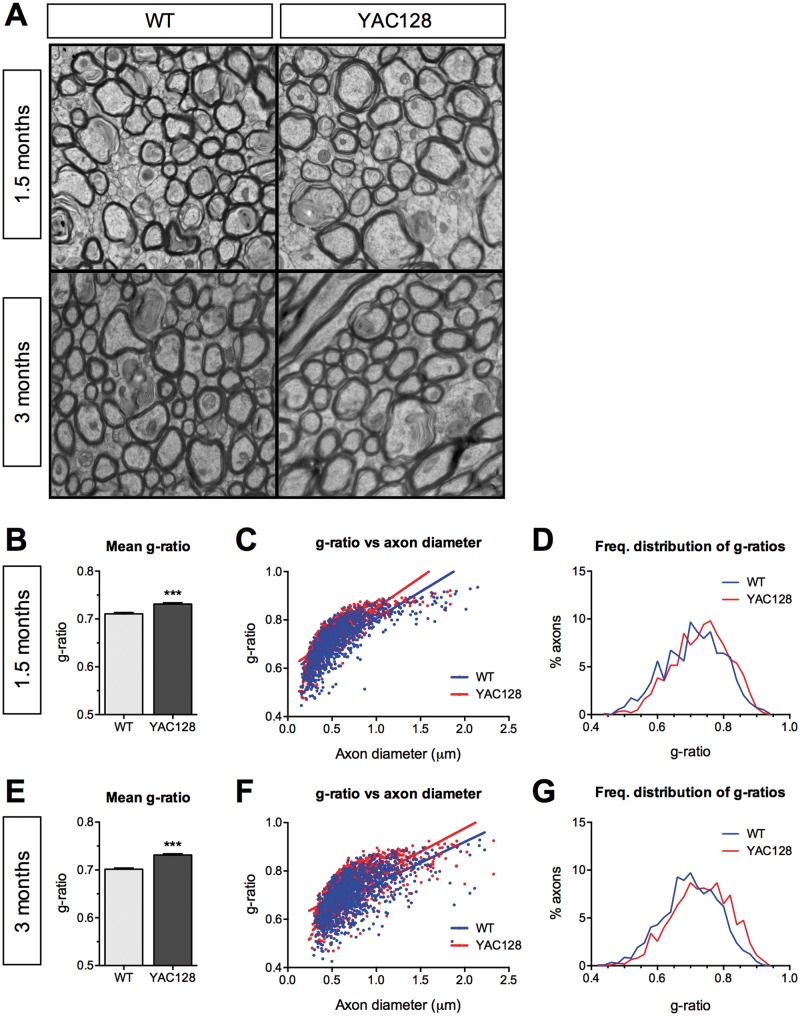
Electronic microscopy analysis shows thinner myelin sheaths in YAC128 HD mice. (A) Representative EM images taken from the corpus callosum of WT and YAC128 mice at 1.5 and 3 months of age. (B) Mean g-ratios were higher in YAC128 mice compared with their WT littermates, indicating that YAC128 mice had thinner myelin sheaths at 1.5 months of age. (C) Scatter plot of g-ratios against axonal diameters with linear regression. The slope of the best-fit line was significantly higher for YAC128 compared with WT mice (P = 0.0004), indicating thinner myelin sheaths in YAC128 HD mice at 1.5 months of age. (D) Frequency distribution of g-ratios of round healthy axons in YAC128 mice at 1.5 months are shifted to the right, suggesting larger numbers of axons with thinner myelin sheaths. (E–G) The mean g-ratios, linear regression of g-ratios and axonal diameter, and frequency distribution of g-ratios in WT and YAC128 HD mice at 3 months showed the same trends as seen at 1.5 months of age. (B and E) Error bars represent the standard error of the mean. (B–G) n = 3 mice (male) per genotype; ∼500 axons analysed per mouse. *** P < 0.001.